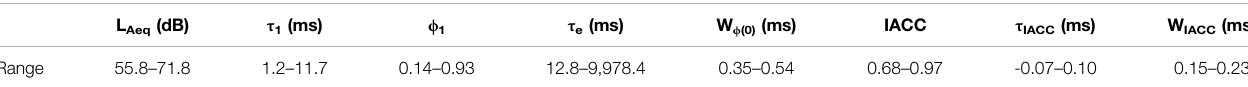
TABLE 1 | Range of mean ACF and IACF values obtained from air-conditioner sounds used in the subjective assessments.